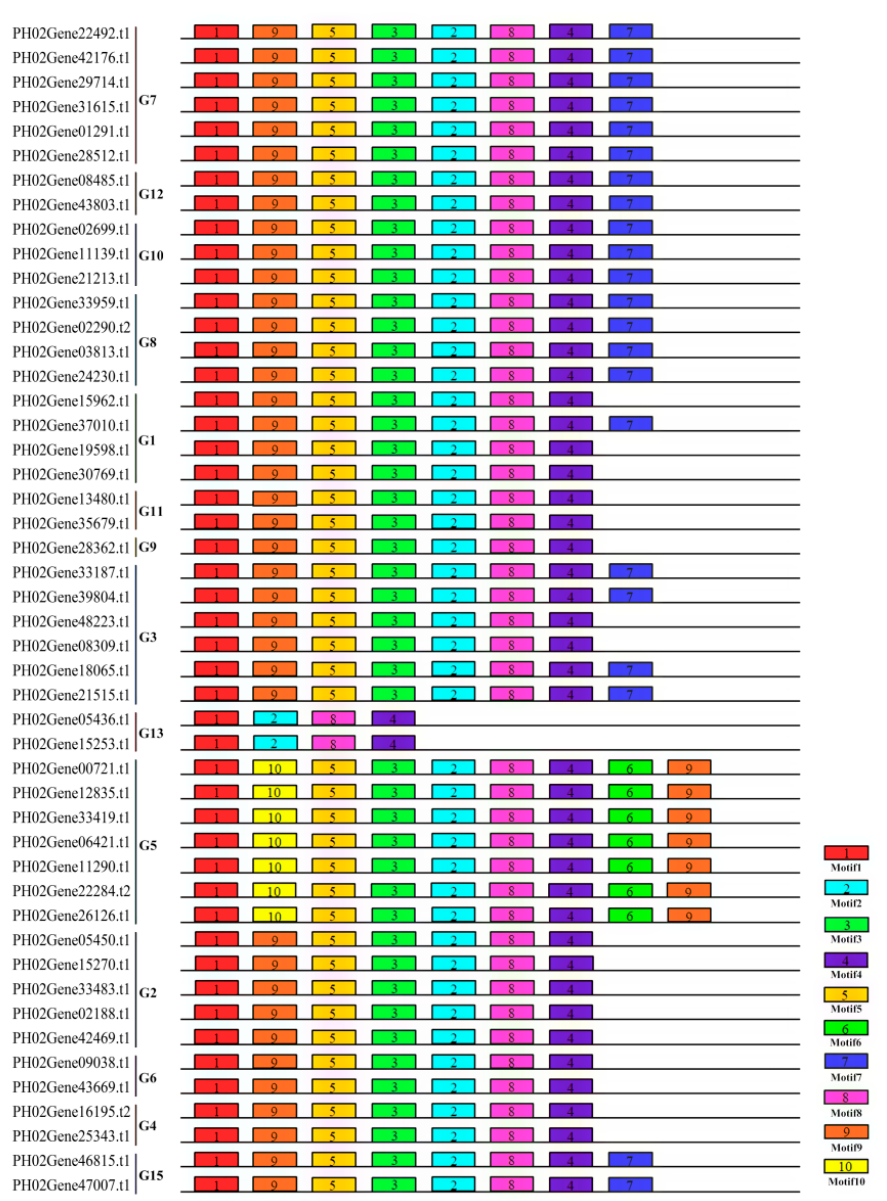
Figure 4. Schematic representation of the ten conserved motifs in PeUBPs. Conserved motifs of the PeUBPs were identified using the online MEME program based on 48 full-length aa sequences. The lengths of the motifs are displayed proportionally. The numbers in boxes (1–10) represent the motif numbers.